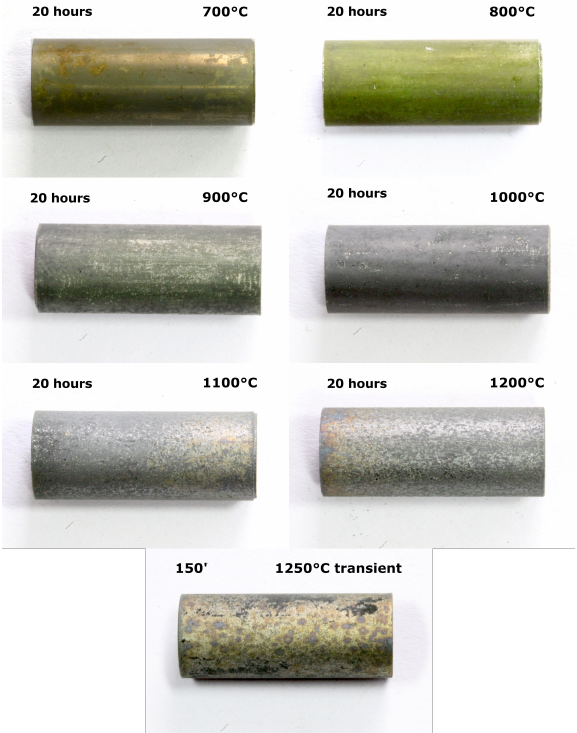
Figure 7. Post-test appearance of Cr-Ni after oxi- dation at temperature transient for 150 minutes and after oxidation in steam at 6 di ff erent temperatures: 700 °C, 800 °C, 900 °C, 1000 °C, 1100 °C, 1200 °C for 20